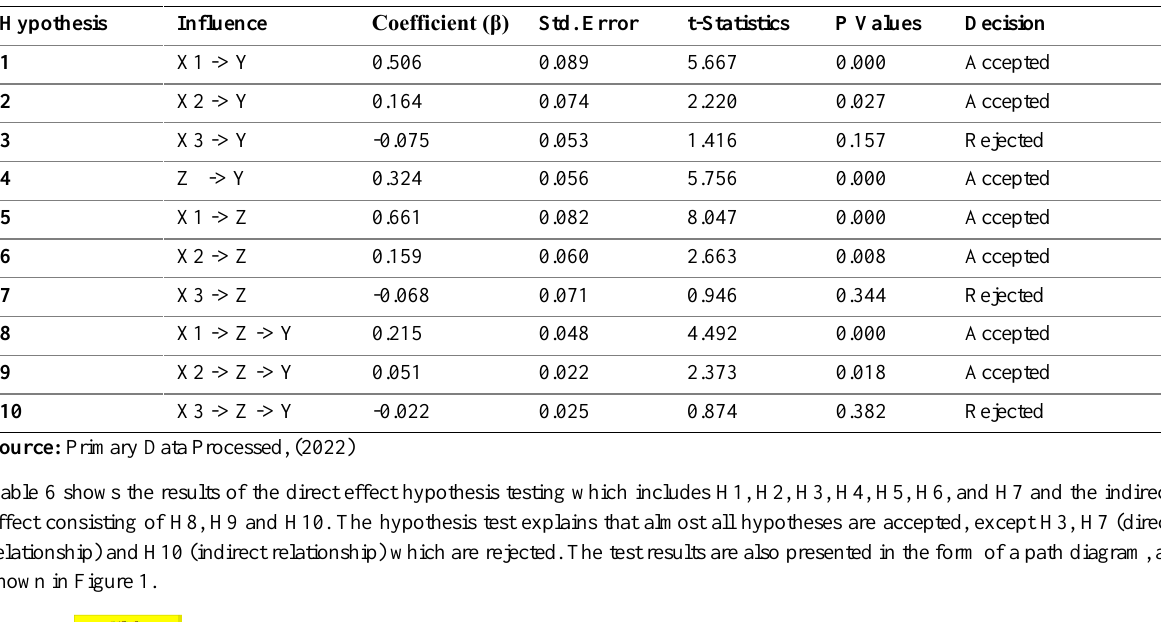
Table 6 : Results of Hypothesis Test for Direct and Indirect Effect